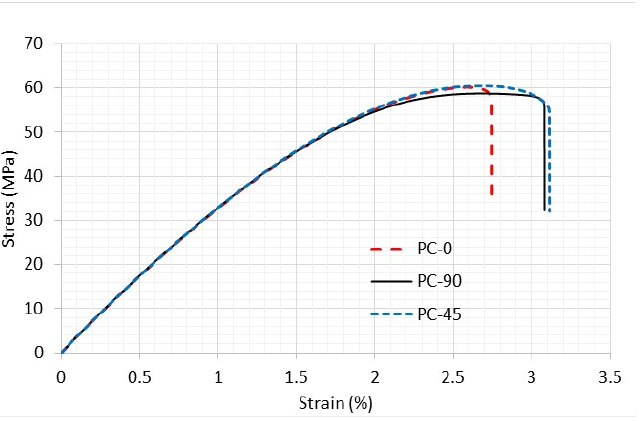
Figure 14. Stress–strain curve of PC specimens without a hole and different printing angles.